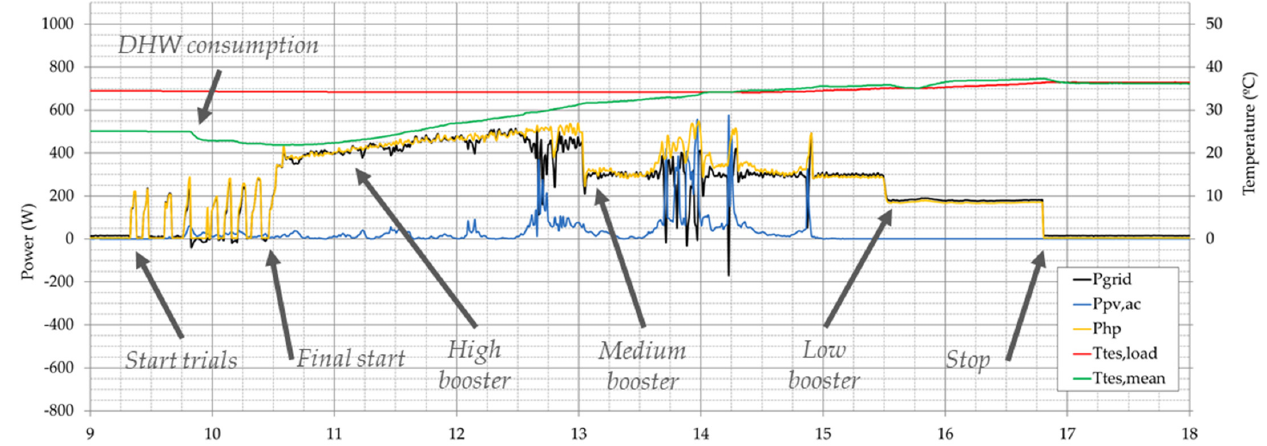
Figure 9. Main system electric power and TES state of charge profiles for the 10 December.